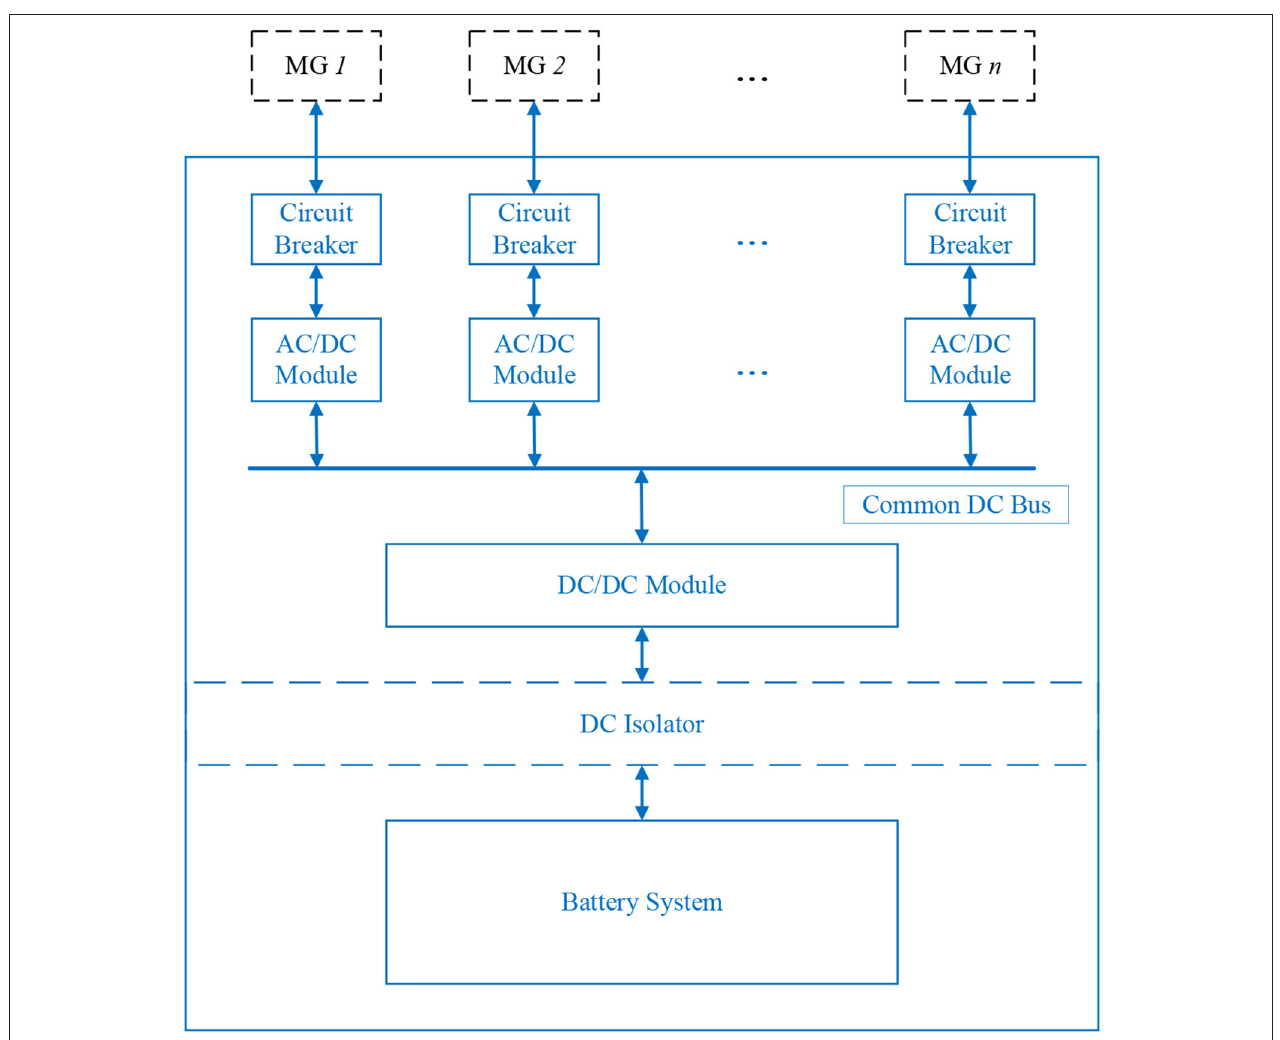
FIGURE 2 | The infrastructure of